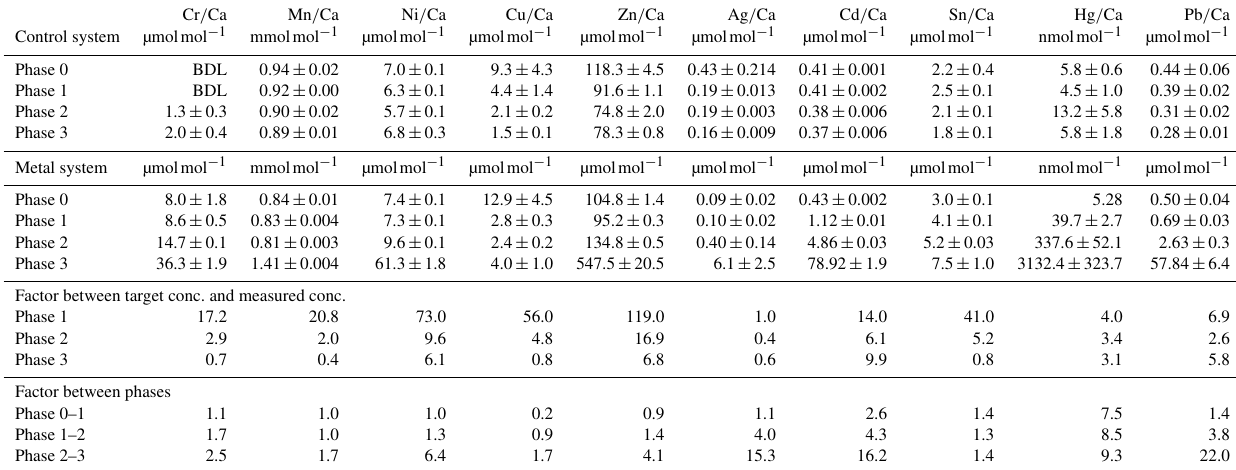
Table 3. Weighted mean TE / Ca values in the culturing medium of the control and the metal system ± the standard deviation of the mean. Furthermore, the factors between the target concentrations (Table 1) and the measured concentrations as well as the factors between individual phases are given. Values given without a standard error originate from only one measurement. Averaged TE / Ca values of a phase were calculated based on single values measured on samples from different days during the culturing phase. These single values can be found in the Appendix (Table